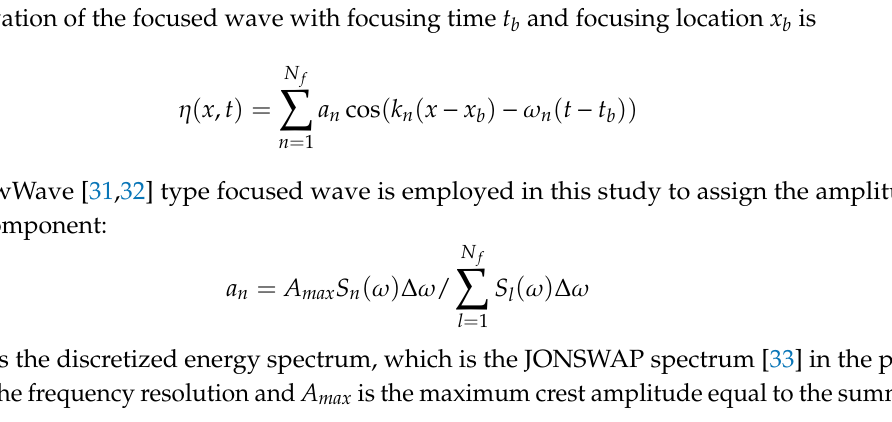
Figure 1. Schematic view of the wave structure system.